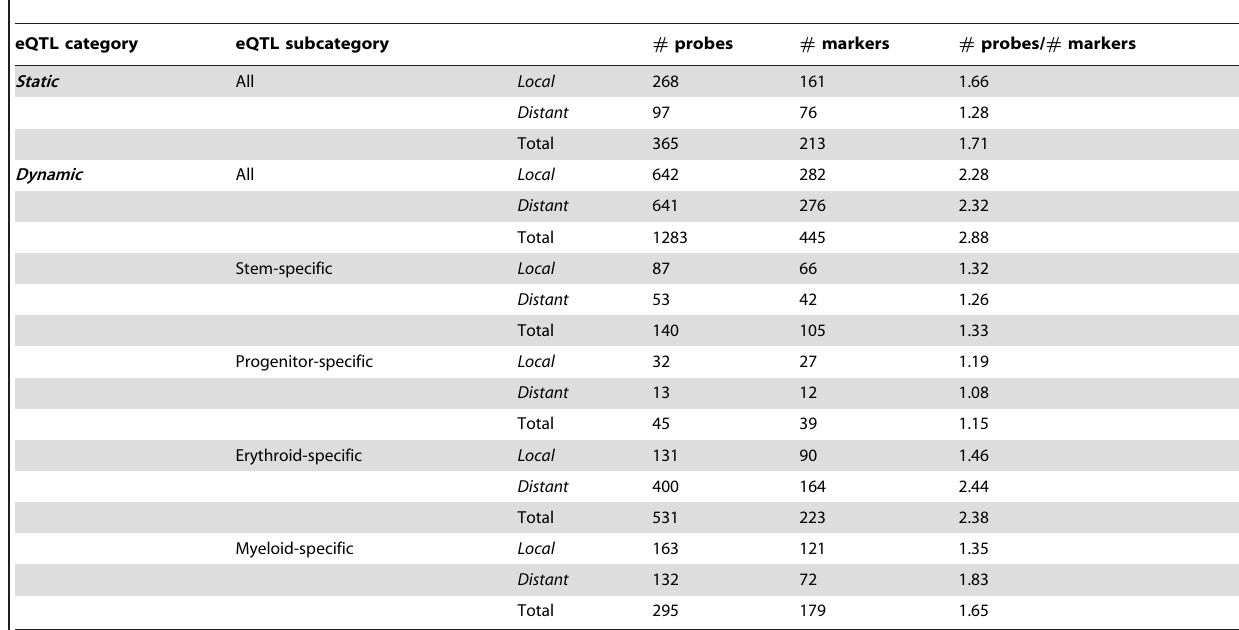
Table 1. Overview of static and dynamic eQTLs ( p , 10 2 6 ): number of probes and associated markers.